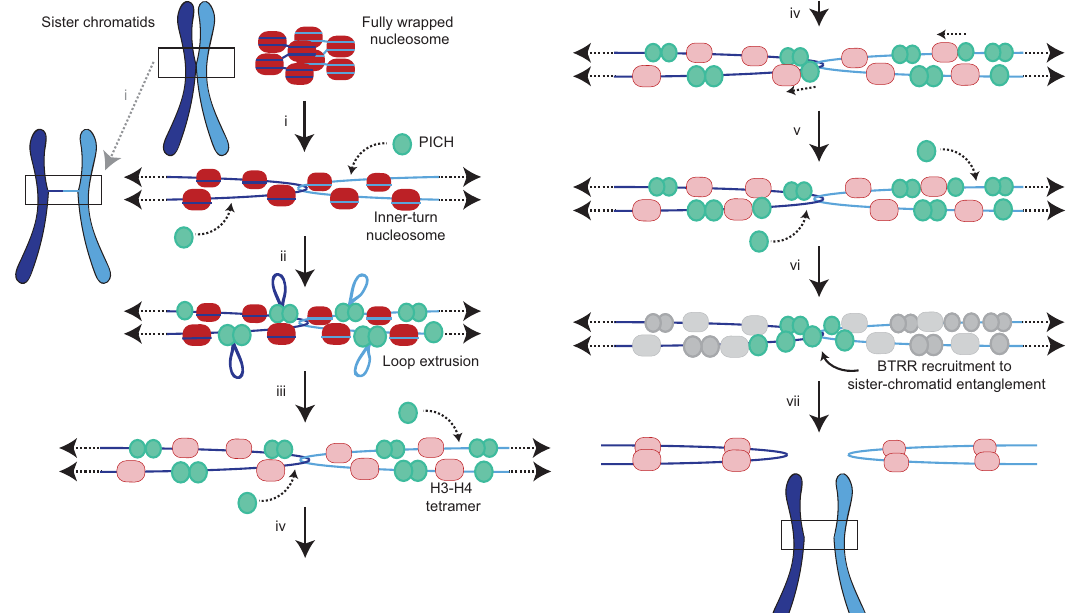
Fig.5|SchematicrepresentationoftheproposedmodelfortheroleofPICHin UFBdissolution.i Attheearlystagesofmitosis,whenlowtensions(representedby black horizontal arrows) are exerted on sister chromatid (purple and light blue) entanglements, nucleosome-nucleosome interactions are disrupted and nucleo- some outer turns are unwrapped. This results in nucleosome-free dsDNA regions between neighboring inner-turn nucleosomes. The bare dsDNA regions will be readily bound by PICH (green). Histone octamers are depicted in red. ii PICH uti- lizes ATP hydrolysis to extrude DNA loops. iii The ATP-dependent loop extrusion by PICH, and likely the accompanying torsional stress, will facilitate inner-turn